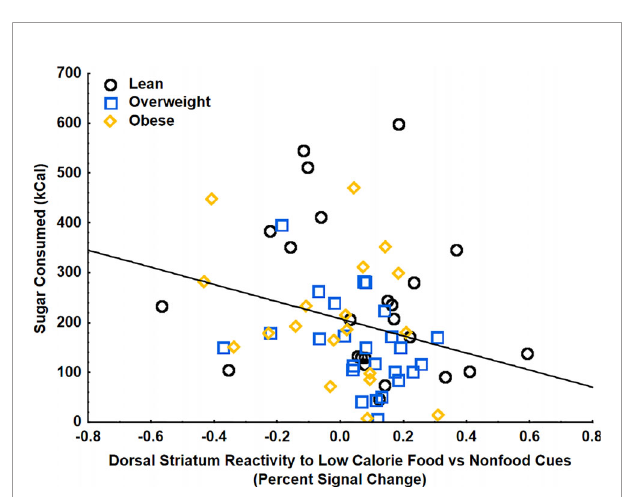
FIGURE 4 | Striatal food cue reactivity to low calorie food vs nonfood cues was negatively correlated with sugar (kcal) consumed at the food buffet on the glucose day (p<.05). These fi ndings were controlled for age, gender, BMI, percent calories from added sugar, and glucose-induced increases in